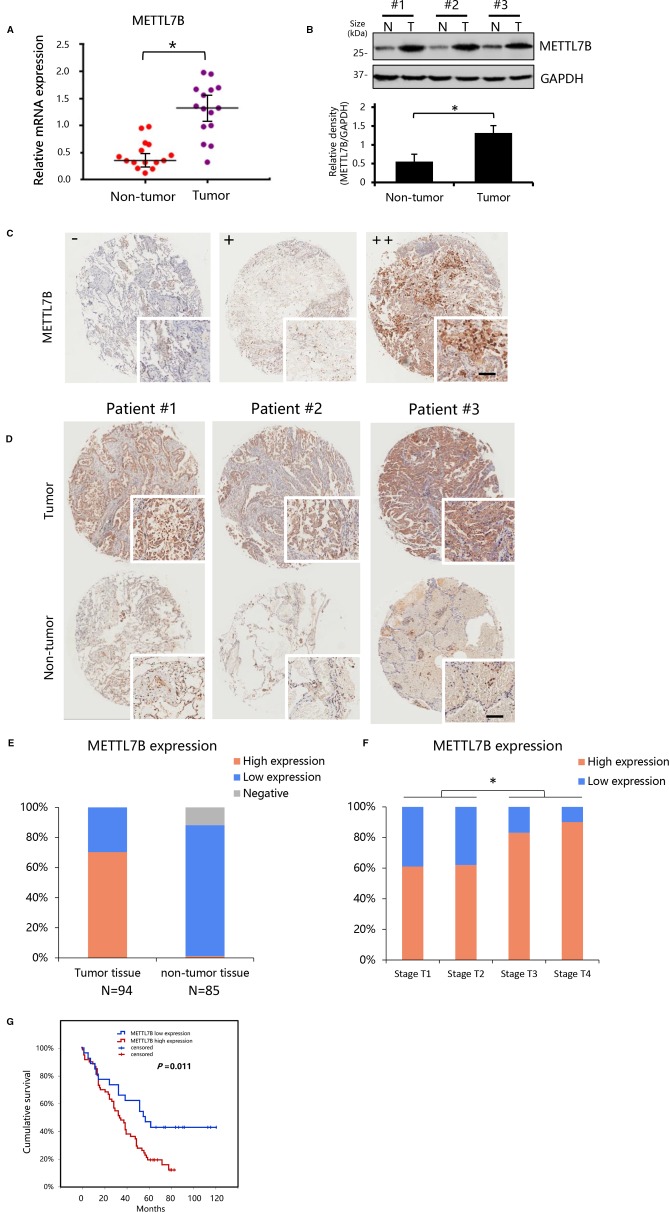
METTL7B up-regulated in clinical lung cancer tissues. (A, B) The expression of METTL7B evaluated in 14 pairs of clinical lung cancer tissues and their matched non-tumor tissues by qRT-PCR (p < 0.05) and Western blot (Data from three representative patients were shown). (B) Data in lower panel represented the density quantification of bands (normalized to GAPDH) for each experimental group, *p < 0.05 vs. non-tumor. N, non-tumor tissues; T, tumor tissue. (C, D) Immunohistochemical staining of METTL7B protein in tumor tissue and matched non-tumor tissues from non-small cell lung cancer (NSCLC) tissue microarray of 95 cases shown at low (×40) and high (×400; bar = 100 μm) magnification. (C) Representative sections for staining intensity “-” negative, “+” low expression, “++” high expression. (D) Immunohistochemical staining images from three representative patients. (E) The METTL7B expression in lung cancer tissues and their matched non-tumor tissues groups. (F) METTL7B expression in tumor tissue with different Tumor (T) stages. (G) Kaplan-Meier survival curve analysis of NSCLC patients with high or low METTL7B expression.